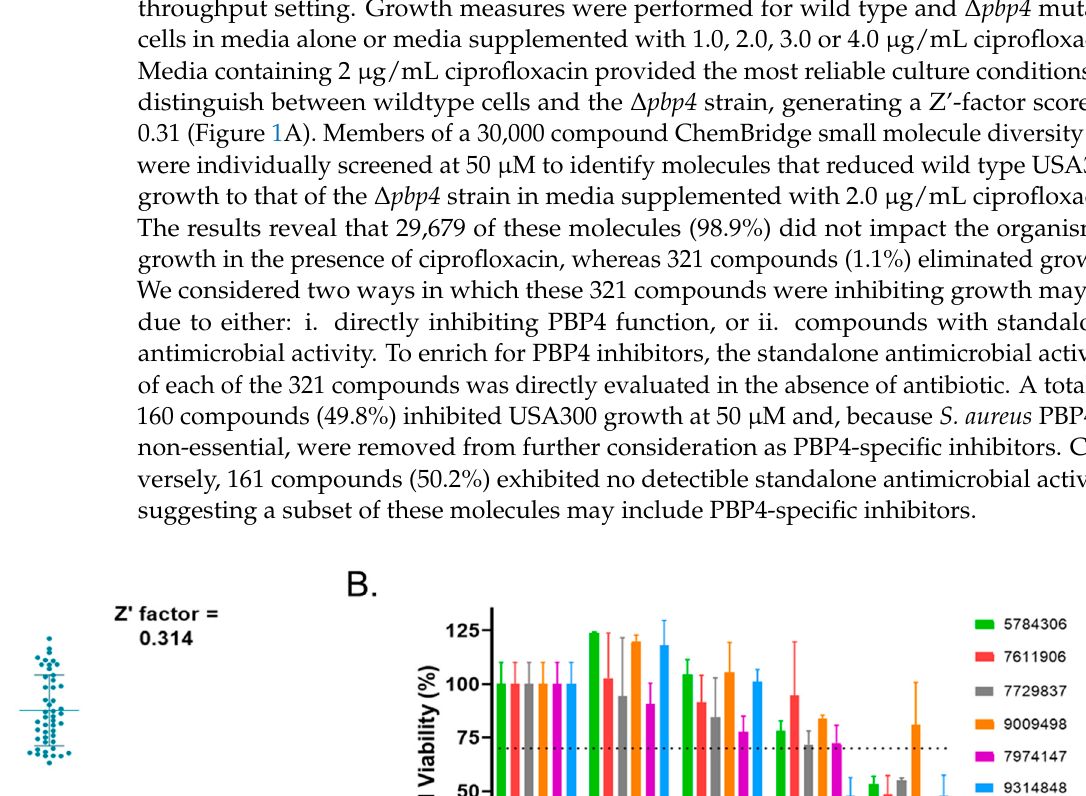
Panel ( A ). Growth of strains USA300 and USA300 ∆ pbp4 in media supplemented with 2 µg/mL